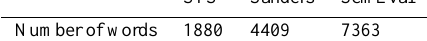
Table 2. Number of words in each dataset.